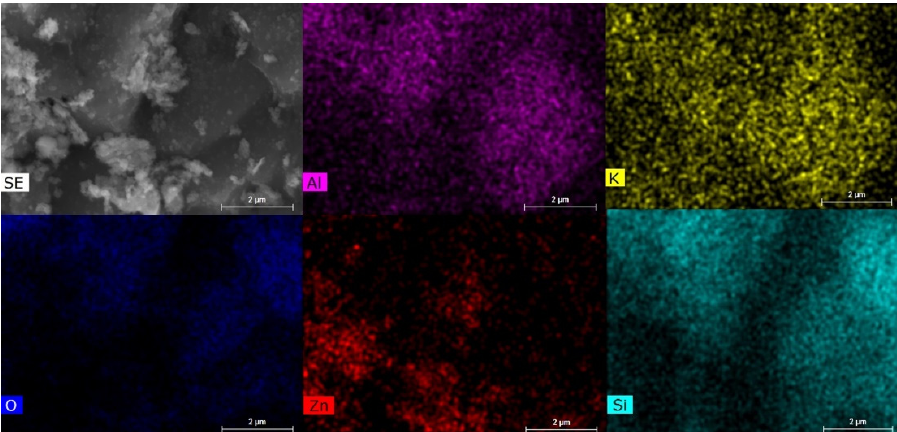
Figure 3. Mapping index of ZnO/Bentonite indicating the presence of essential elements of bentonite (i.e., Al, K, and Si), and Zn conforming to the formation of ZnO in the composite material.